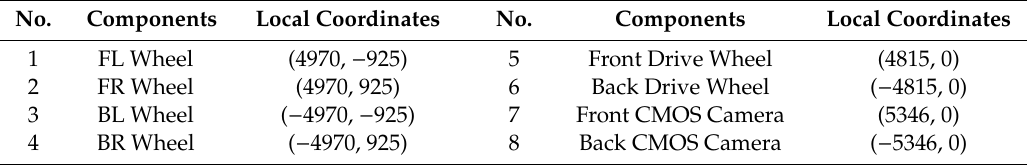
Table 2. Local coordinates of the wheels and